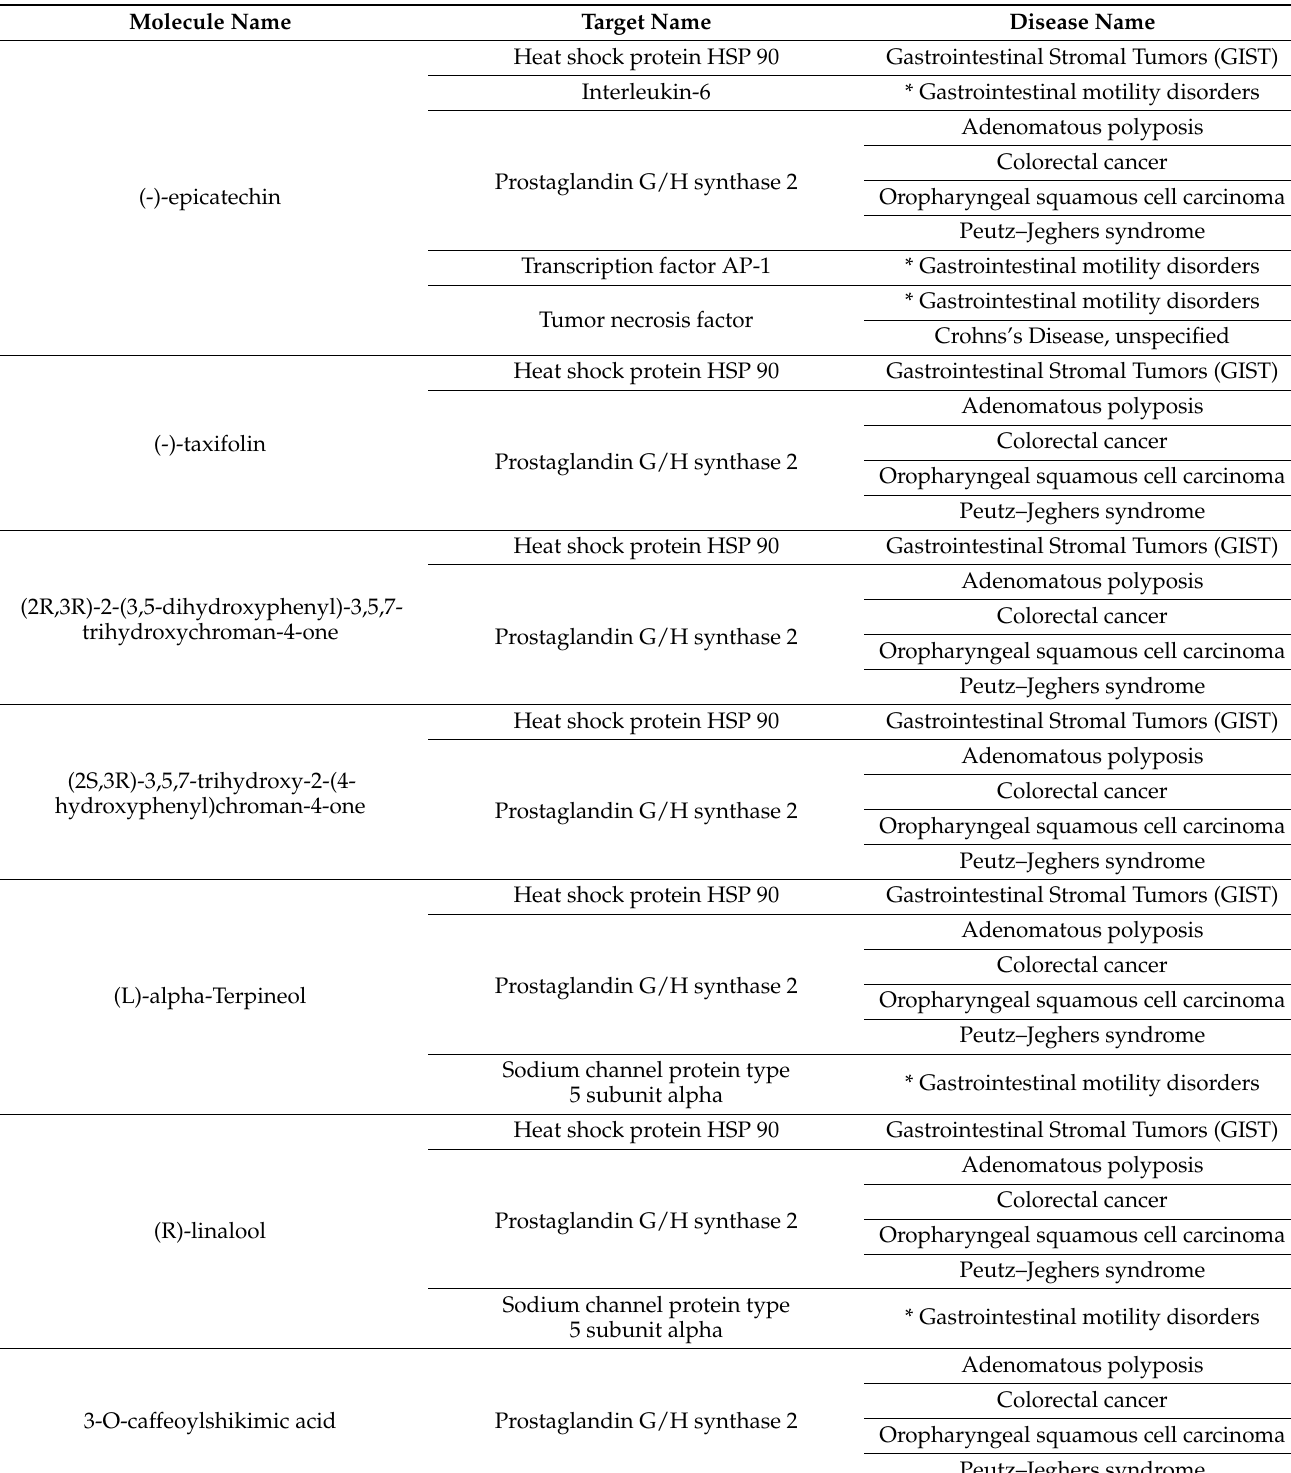
Table 2. Compounds and targets related to gastrointestinal